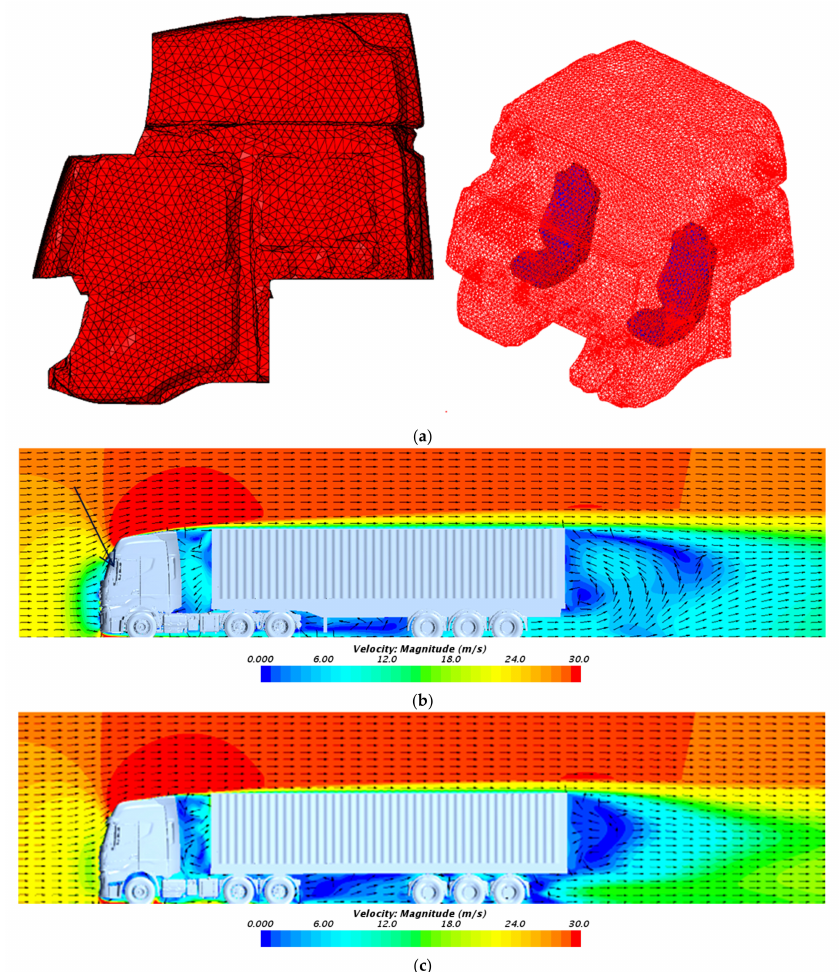
Figure 11. Internal and external sound fields. ( a ) The internal sound chamber of the cab; ( b ) External sound fields at different velocities (70 km/h); ( c ) External sound fields at different velocities (80